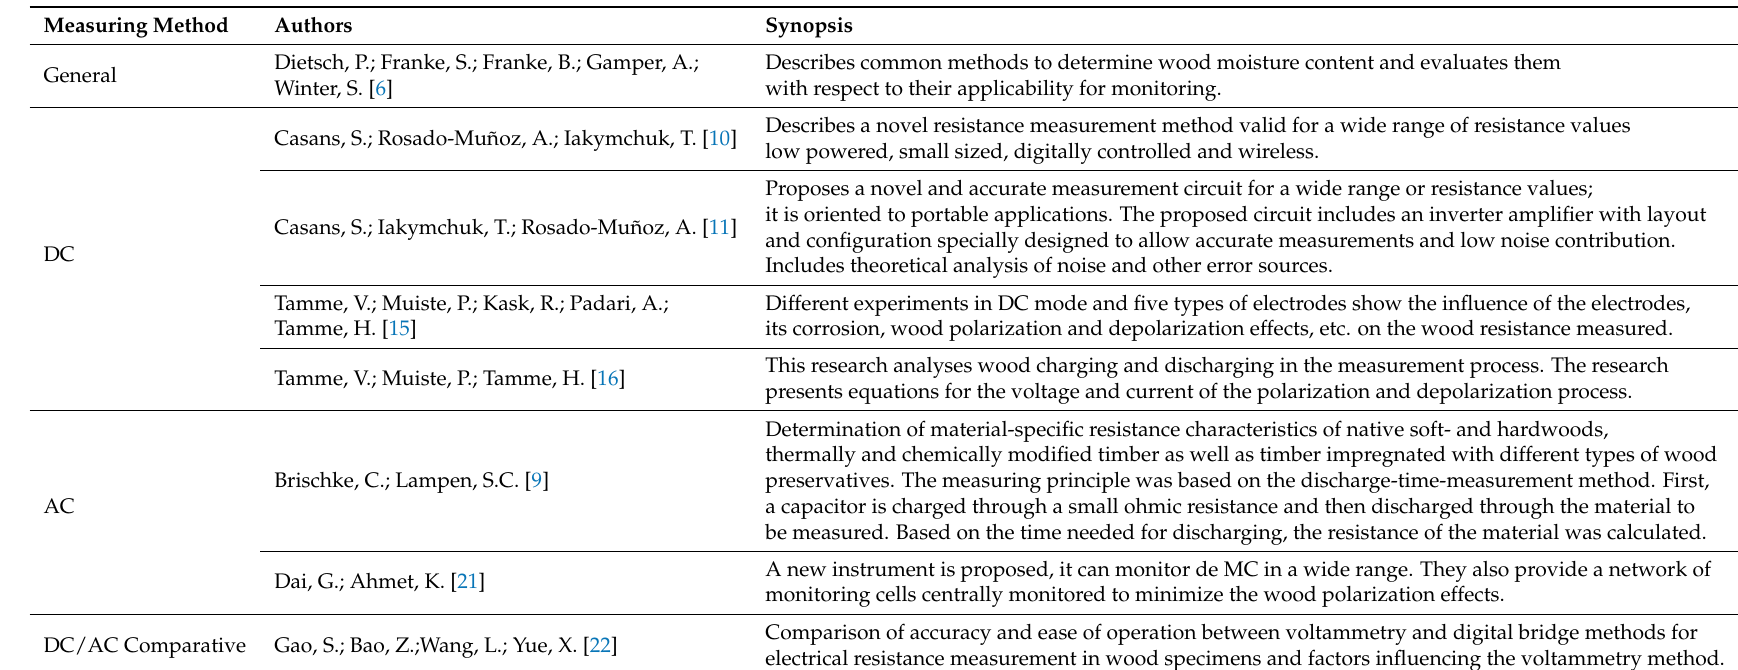
Table 1. State-of-the-art literature review on resistance measuring